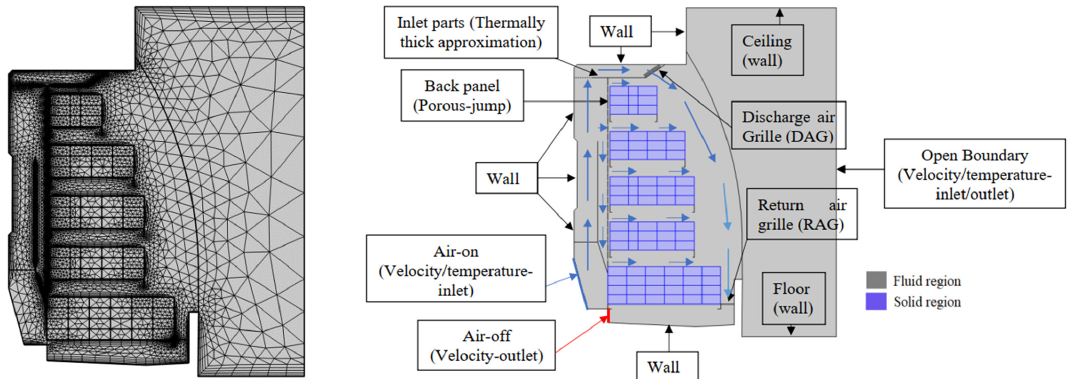
Figure 3. 2D mesh applied to the cabinet model ( left ); the computational domain of the 2D-CFD model for an open display cabinet and the locations of boundary conditions ( right ).